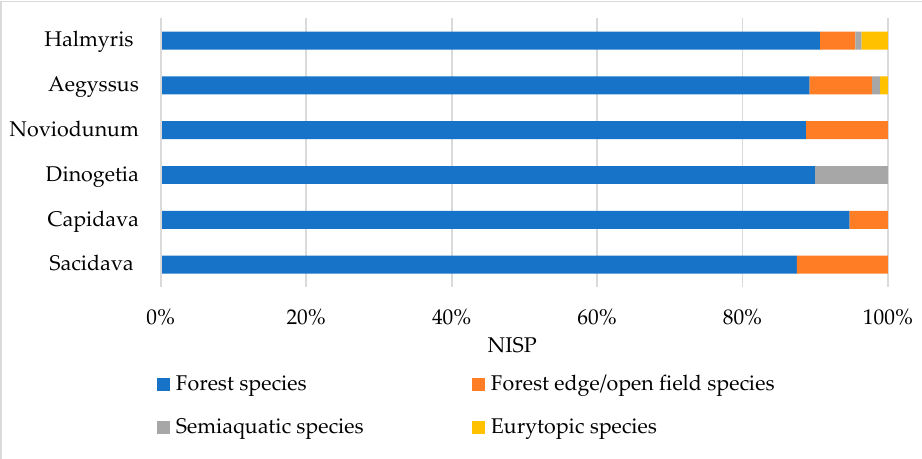
Figure 4. Proportions of wild mammal species by ecological group.